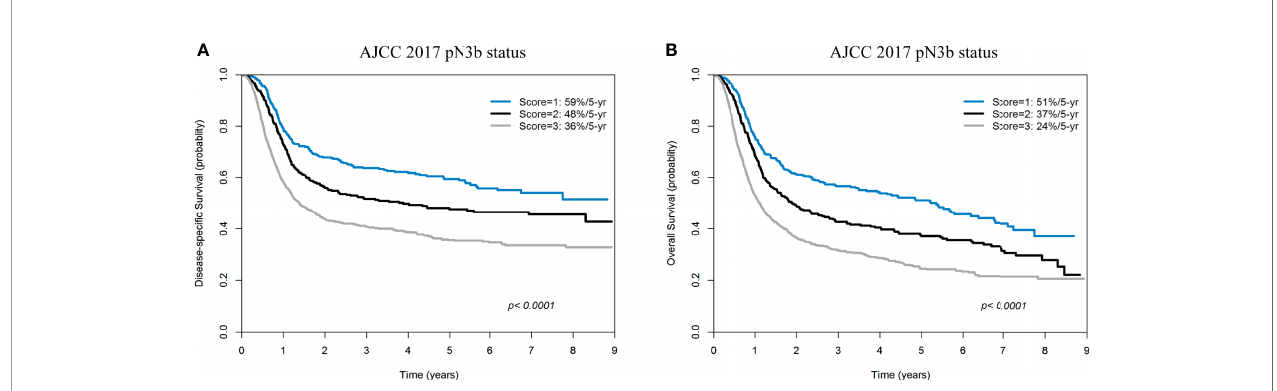
FIGURE 5 | Kaplan-Meier plots of 5-year disease-speci fi c survival (A) and overall survival (B) in patients with pN3b disease (AJCC pN classi fi cation) strati fi ed according to a score of 1 −